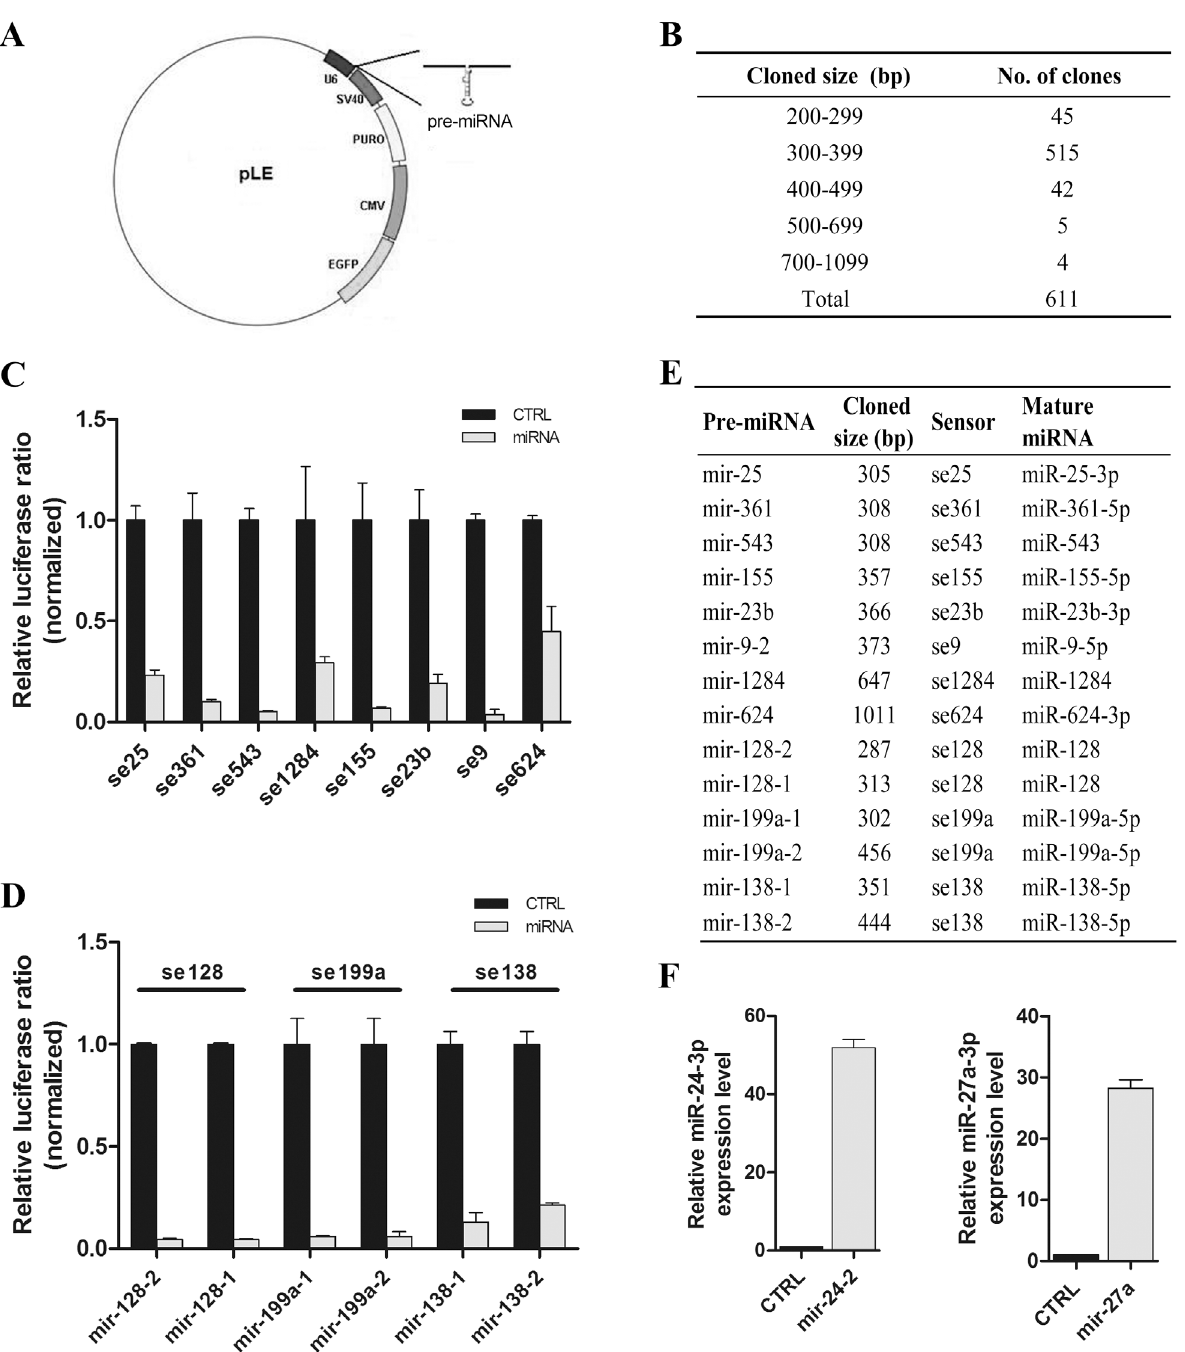
Figure 1. The human miRNA expression library. (A) The map of the miRNA expression vector contains the puromycin resistance gene and EGFP reporter gene. The miRNA precursor and flanking sequences were cloned into the downstream of the U6 promoter (see Materials and Methods). (B) The size distribution of the inserts containing each miRNA precursor and flanking genomic sequences in the constructed miRNA expression library. (C) and (D) The pre-miRNA expression vector and cognate miRNA sensor were co-transfected in 293T cells to test whether the construct could express the miRNA triple repeats for each experiment (p , 0.05). The results of one sensor corresponding to one pre-miRNAgenomic locus are shown in (C) and the results of one sensor corresponding to two pre-miRNA genomic locus are shown in (D). The co-transfection of the empty vector of miRNA and the same sensor was used as a control. (E) The detailed information of each sensor and tested miRNA that were demonstrated in (C) and (D). (F). Relative levels of miR-24-3p and miR-27a-3p miRNAs measured by qPCR for transient transfection of each pre-miRNA expression vector in 293T